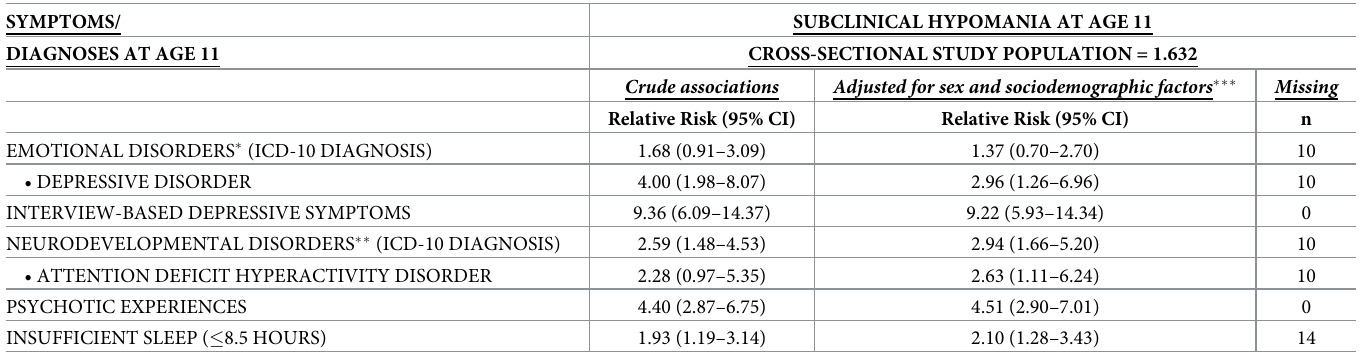
Table 3. The association between symptoms/ diagnoses at age 11 and subclinical hypomania at age 11.